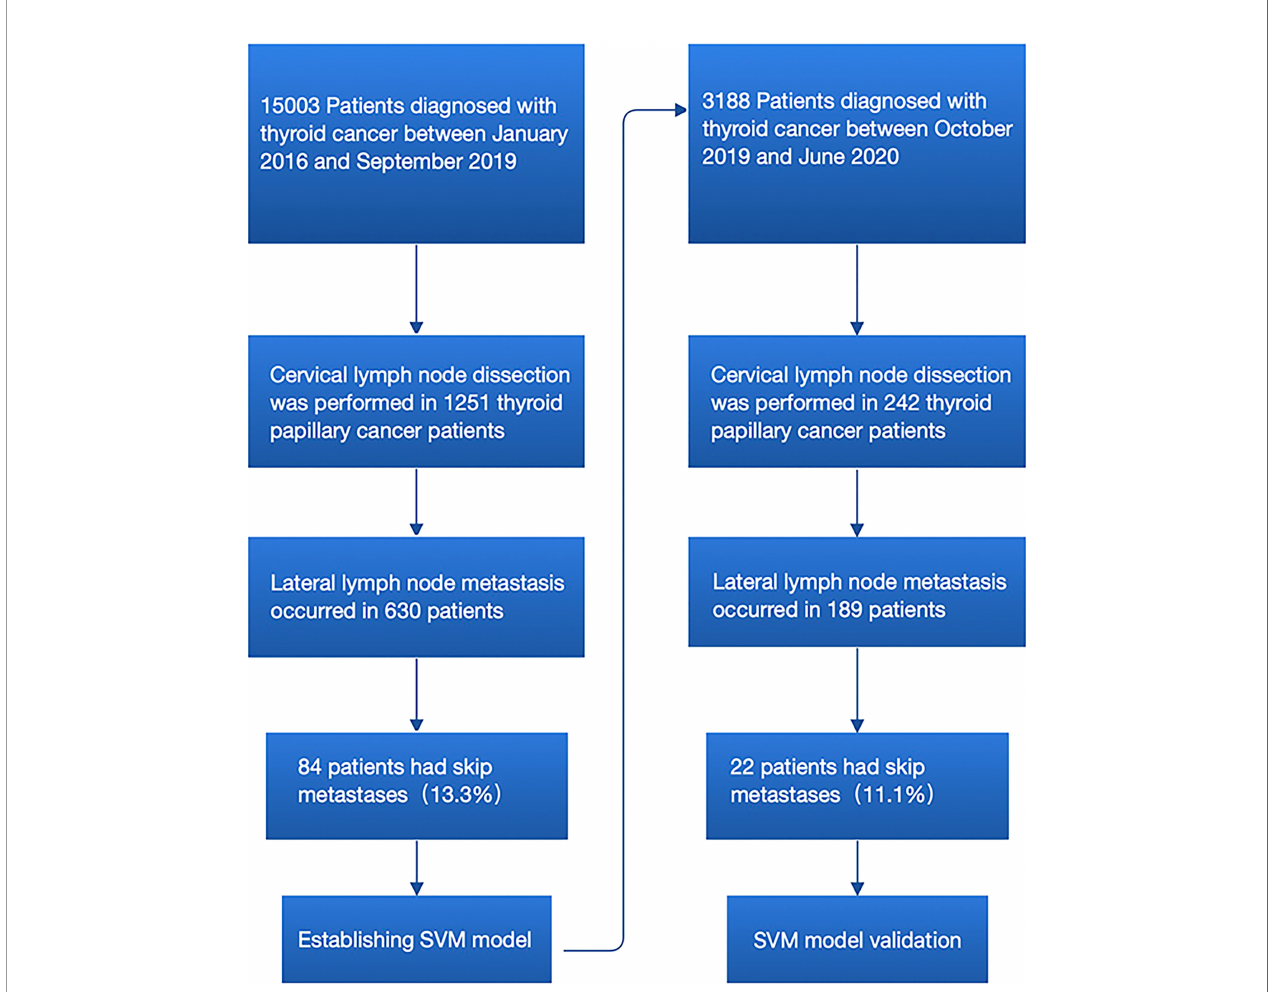
FIGURE 1 | Flowchart for the process of establishment and validation of skip metastasis prediction model of